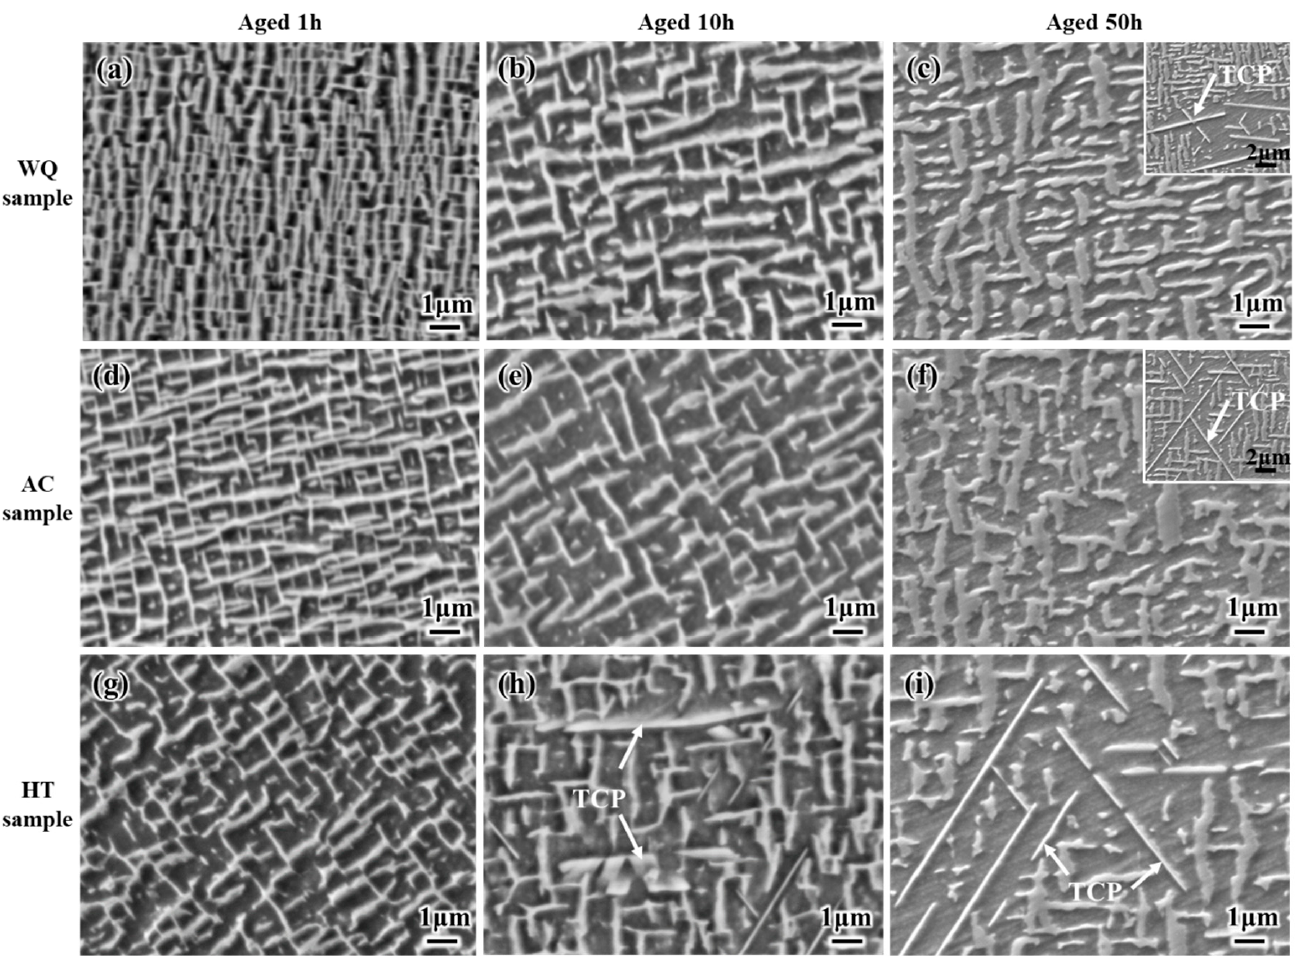
Figure 7. The SEM-SE microstructure evolution of γ′ phase after different heat treatment during thermal exposure at 1100 °C: ( a – c ) WQ samples; ( d – f ) AC samples and ( g – i ) HT samples.